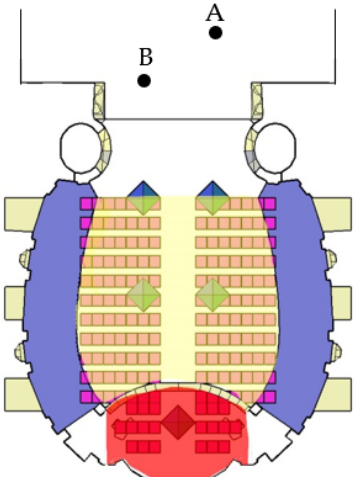
Figure 14. Plan of the theatre with the three groups of receivers: stalls in yellow, gallery in blue, and Prince’s box in red.